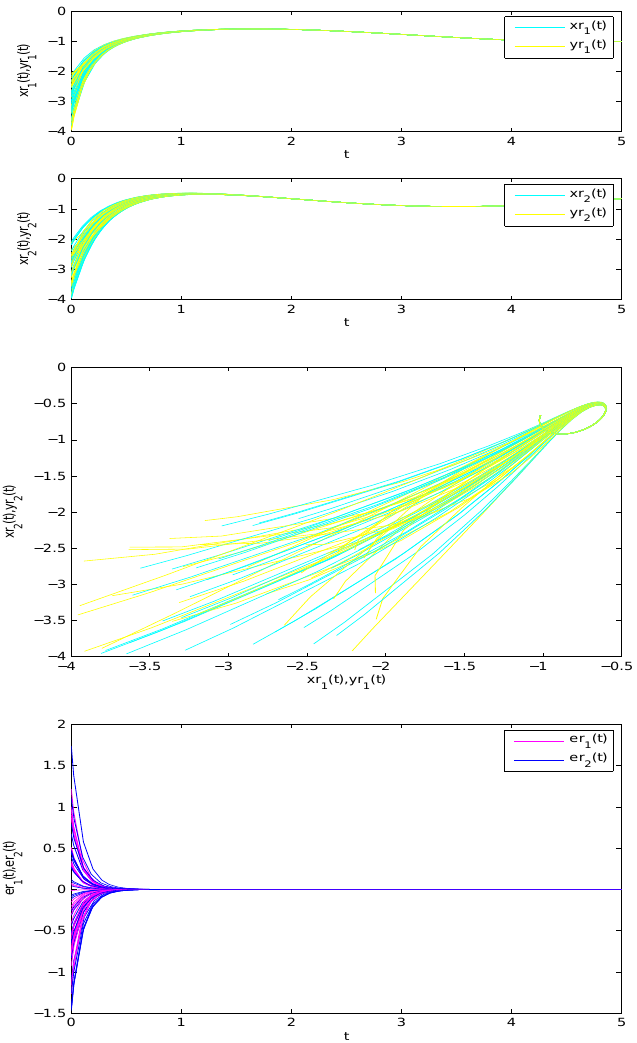
Figure 1. Instantaneous error states for the R part between for the variable ˘ x of (18) and ˘ y of (19) under 30 random initial values for asymptotical